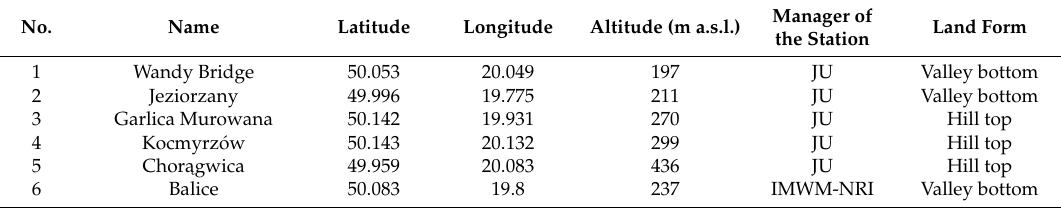
Table 1. Meteorological stations/measurement points used in the study. JU, Jagiellonian